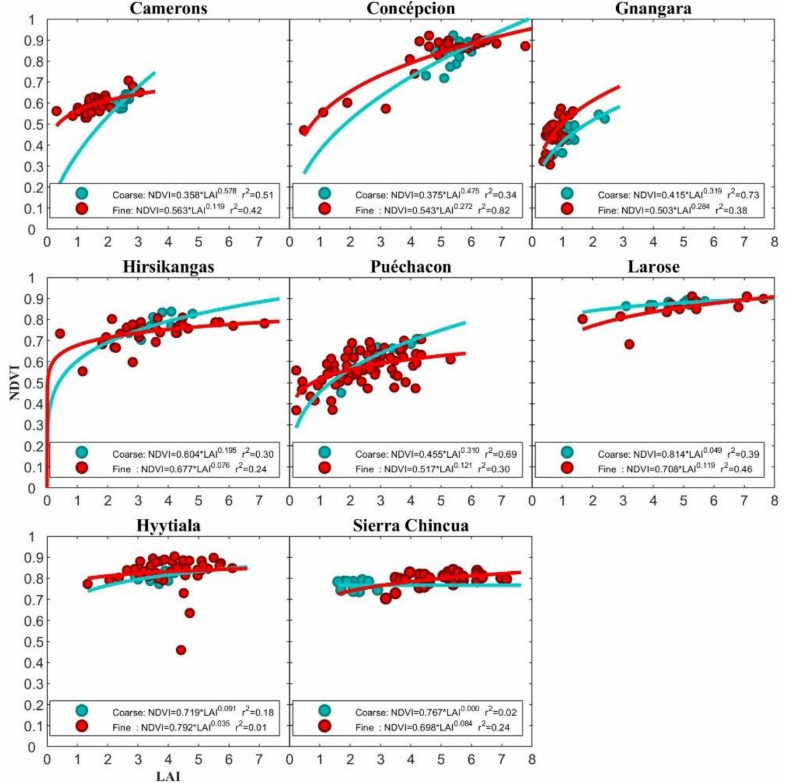
Figure 4. NDVI-LAI statistical models of the 8 forest sites. The red points represent the (LAI, NDVI) dataset with 30 m spatial resolution, the red curves represent the model f ( p ) at 30 m spatial resolution, the aquamarine points represent the (LAI, NDVI) dataset with 1 km spatial resolution and the aquamarine curves represent the model F ( P ) at 1 km spatial